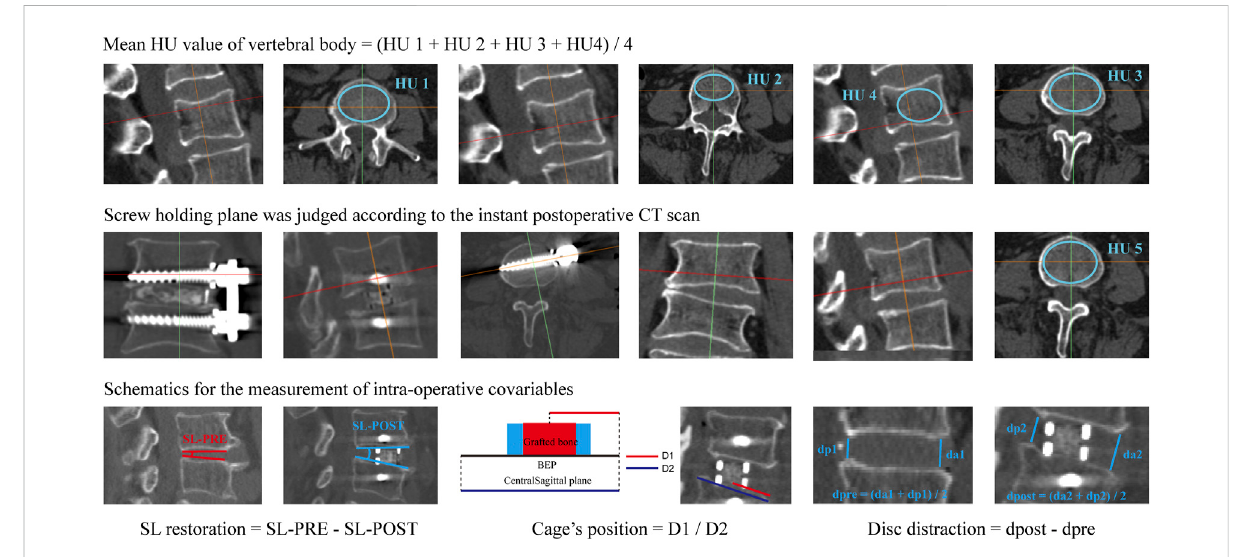
FIGURE 1 SchematicofdifferentHUmeasurement methodsandthemeasurementofintraoperativecovariables. HU1,HUinthetransverseplanecloseto thesuperiorBEP;HU2,HUinthecentraltransverseplane;HU3,HUinthetransverseplaneclosetotheinferiorBEP;HU4,HUinthemidsagittalplane; The mean value of HU1 to HU4 was de fi ned as the mean HU of the vertebral body; HU5, HU value of the screw holding